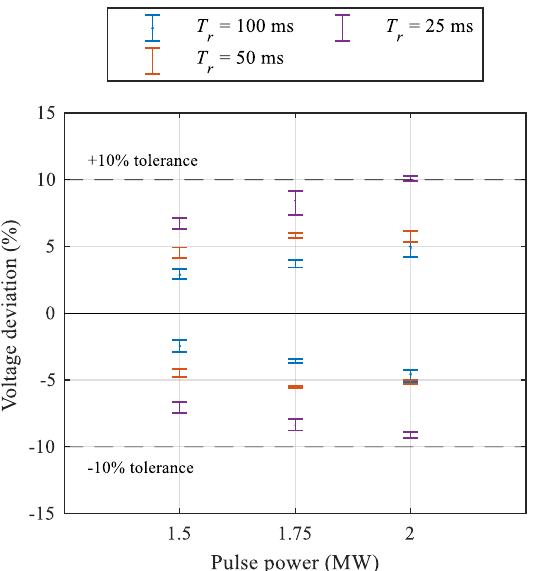
Figure 8. Maximum voltage deviation on the output LDEW bus showing upper and lower bounds of voltage deviation for Study 1.